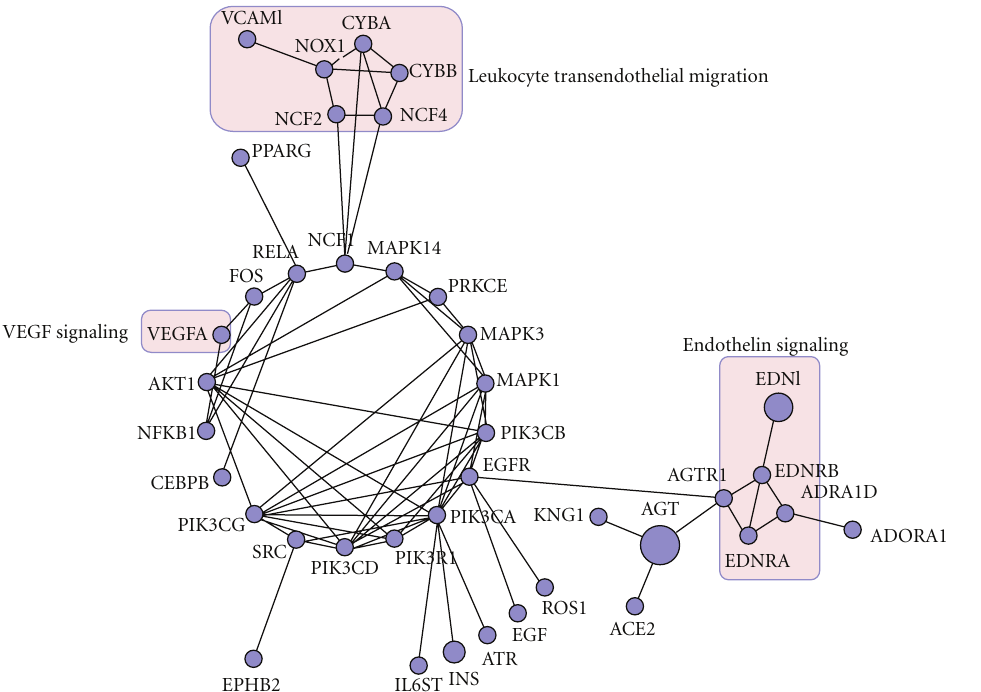
Figure 3: Protein interaction network of highly connected proteins associated with the cardiorenal syndrome. Nodes represent genes (gene symbols); edges indicate functional associations. Highlighted nodes represent proteins that are specific for either the VEGF signaling, the leukocyte transendothelial migration, or the endothelin signaling